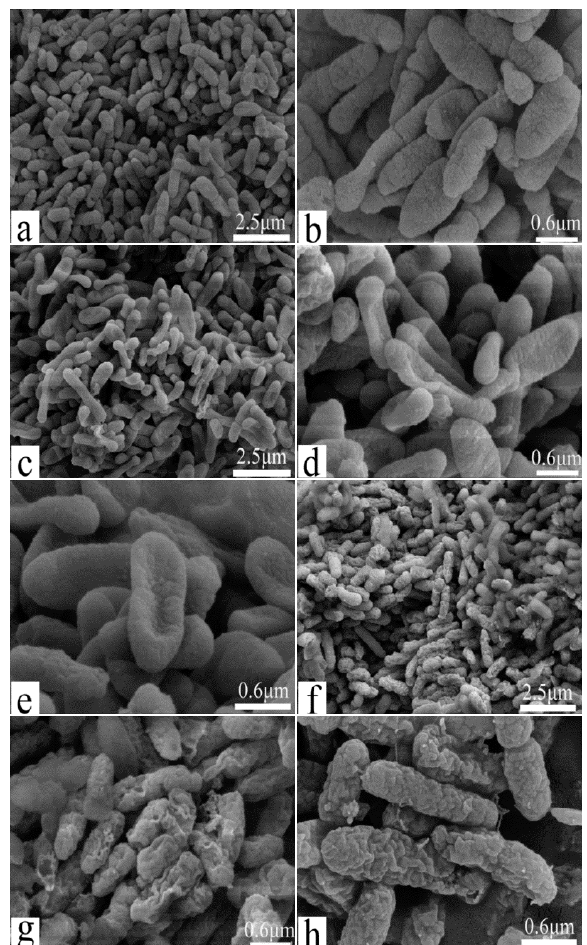
Figure 5. Changes in cell morphology and membrane damage as detected by field emission scanning electron microscopy. Control bacteria ( a , b ); approximately 9 × 10 8 CFU/mL multidrug-resistant P. aeruginosa cells were treated with 10 µ g/mL ( c – e ) POGH for 60 min, or with 30 µ g/mL ( f – h ) POGH for 60 min. Magnification times (( a , c , f ), 4000×; ( b , d , e , g , h ), 16,666×).